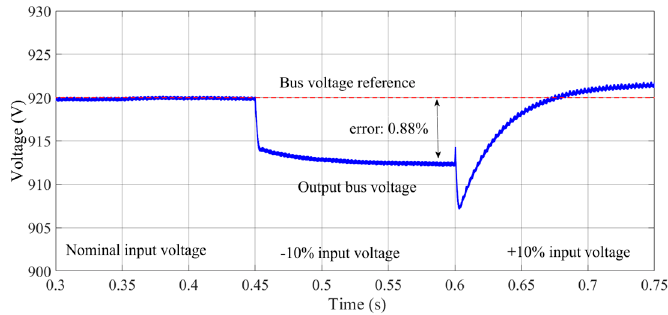
Figure 13. Output voltage 𝑉 (cid:3005)(cid:3004) during the duty class.